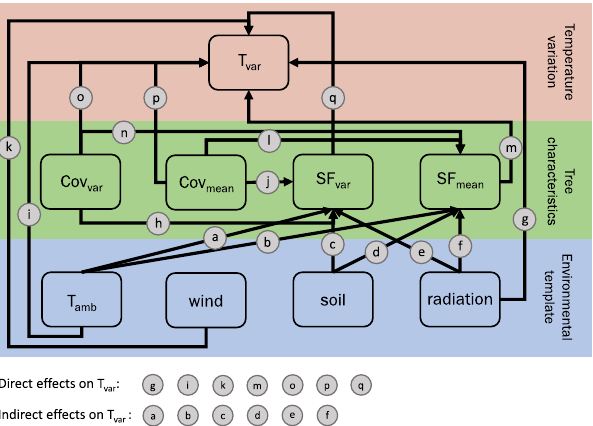
Figure 6. Conceptual SEM structure used to test for direct effects of tree characteristics and the environmental template on variations in canopy temperatures (T var ) and the factors moderating transpirational performance of trees; Cov var = interspecific variation in canopy cover, Cov mean = mean canopy cover, SF var = interspecific variation in sap flow density, SF mean = mean sap flow density, T amb = ambient temperature, wind = wind speed, soil = soil moisture, radiation = total solar